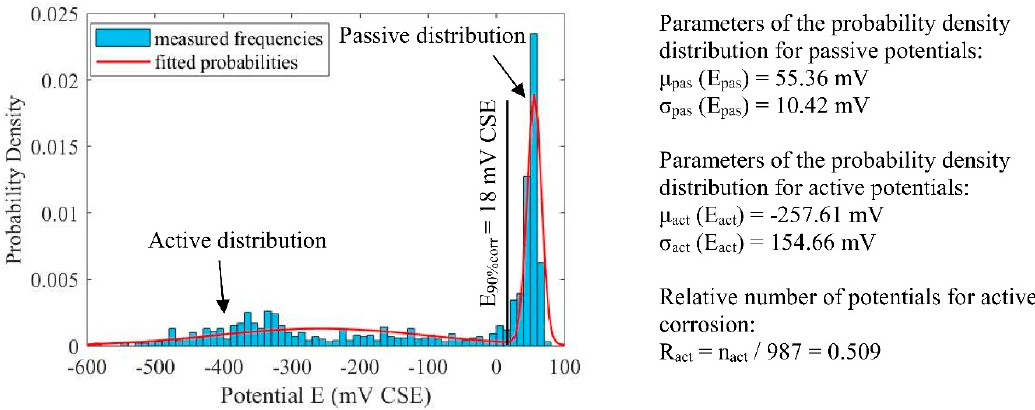
Figure 12. Frequency density distribution of measured and fitted potentials assuming homogenous environmental exposure in Girder 2. Parameters of the potential distributions.